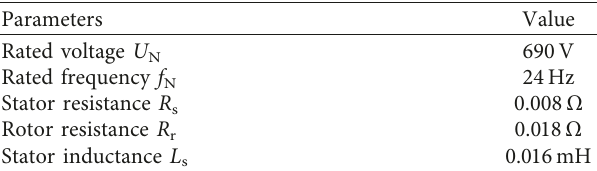
Table 5: Parameters of driving